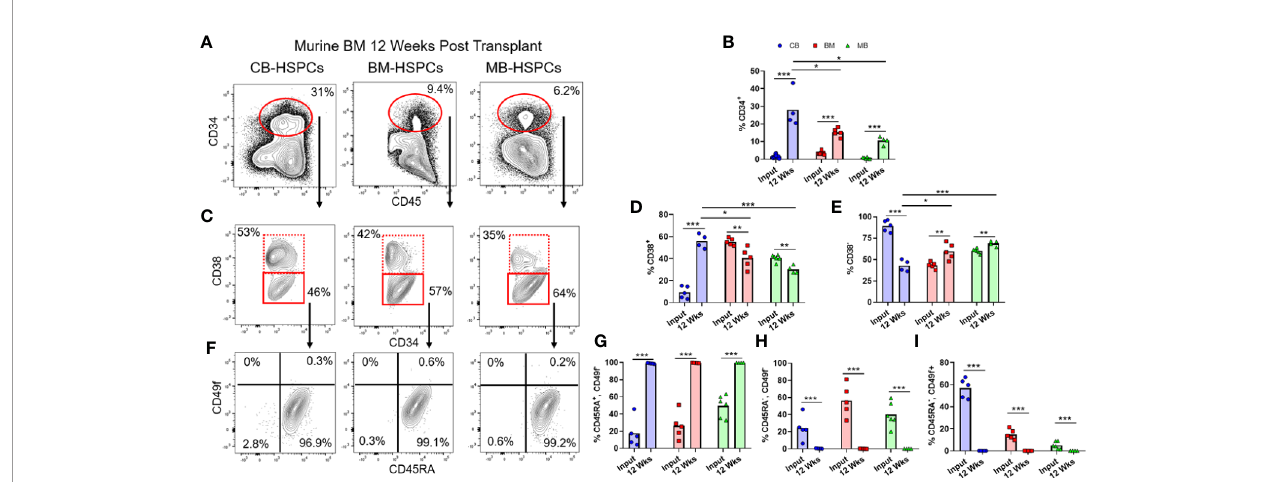
FIGURE 5 | Shift towards short-term HSPC phenotype after transplantation. Flow cytometric analysis was performed to assess the composition of the CD34 + HSPC population within the human compartment in the murine bone marrow at 12 weeks post-transplantation. (A) Representative fl ow cytometry plots showing identi fi cation of human CD34 + population. (B) Plot showing percentage of CD34 + cells detected in bone marrow of mice transplanted with the indicated sources of HSPCs compared to the frequency of total CD34 + cells in the starting graft tissue (Input). (C) Representative plots showing fl ow cytometric staining of human CD34 + cells in murine bone marrow for CD38. (D, E) Percentage of cells in the CD38 + (D) or CD38 − (E) gates after transplantation compared to the starting graft (Input). (F) Representative plots showing fl ow cytometric staining of human CD34 + CD38 − cells in the murine bone marrow for CD45RA and CD49f. (G – I) Percentage of CD34 + CD38 − cells corresponding to uncommitted progenitor (CD45RA + CD49f − , G ), multipotent progenitor (CD45RA − CD49f − , H ), and long-term HSC (CD45RA - CD49f + , I ) gates after transplantation compared to the starting graft (Input). Symbols show results from individual mice; bars represent the arithmetic means. *p < 0.05; **p < 0.01; ***p <